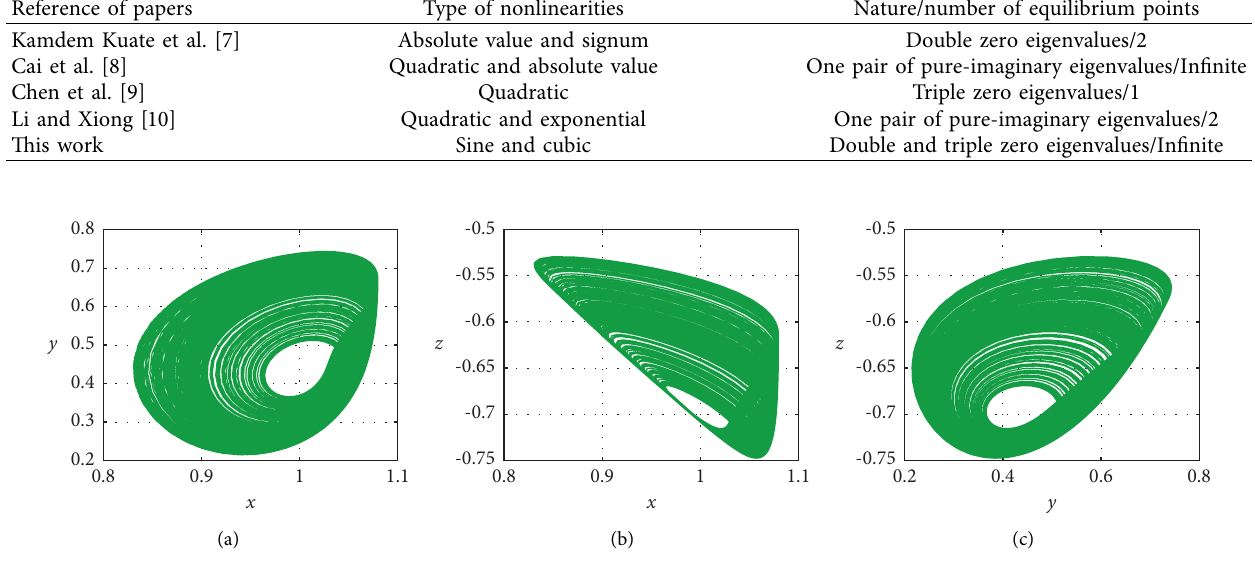
, p ,p , p ,p , p , p )� ( 3 . 964 , 7 , 7 , 5 , 4 . 5 , 2 . 9 , 1 ) and initial value ( − 1, − 1, − 1) projected on 1 2 3 4 5 6 7